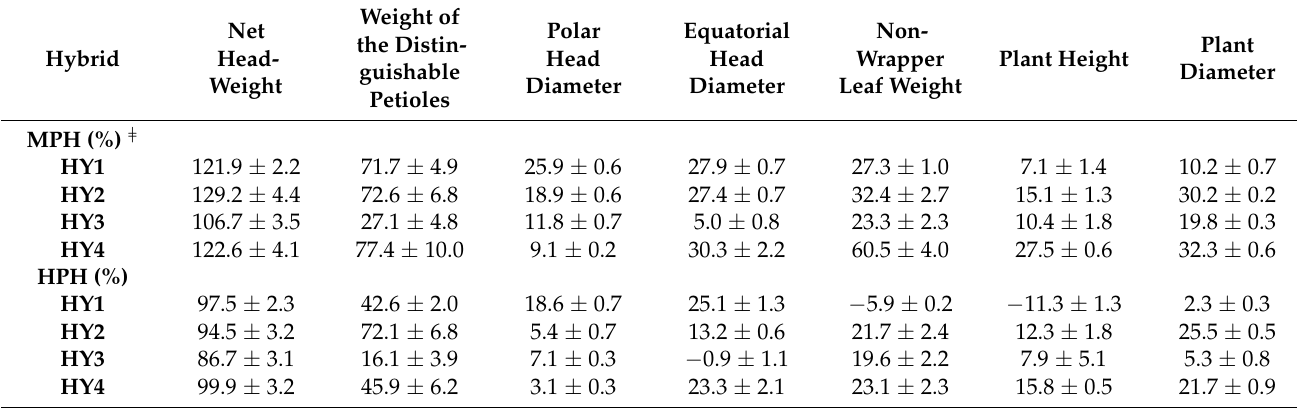
Table 1. Mid-parent heterosis (MPH) and high-parent heterosis (HPH) values for different horticultural traits of the cabbage